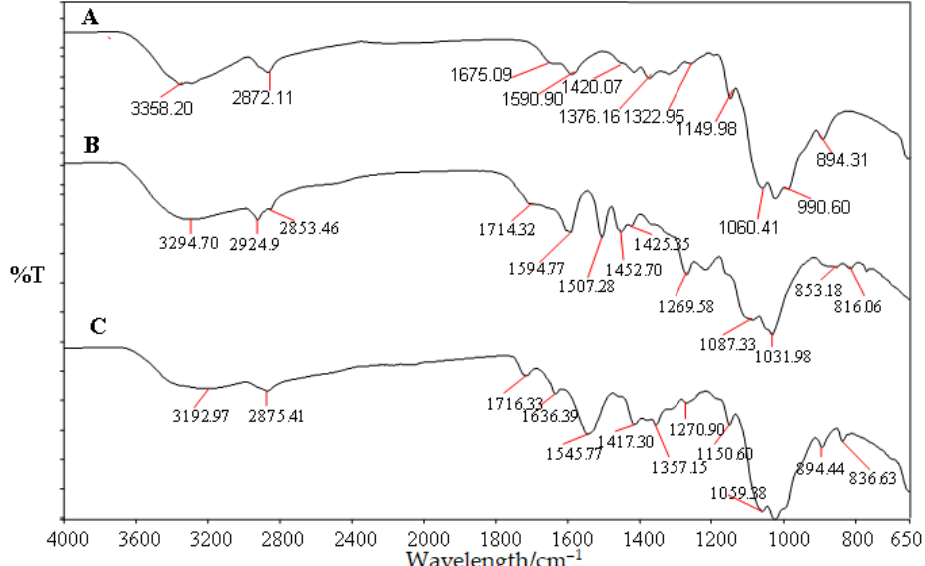
Figure 1. FTIR spectra of unmodified chitosan fiber and modified chitosan with PAA-g-OSL. ( A ) chi- tosan, ( B ) PAA-g-OSL modifying agent, ( C ) modified chitosan with